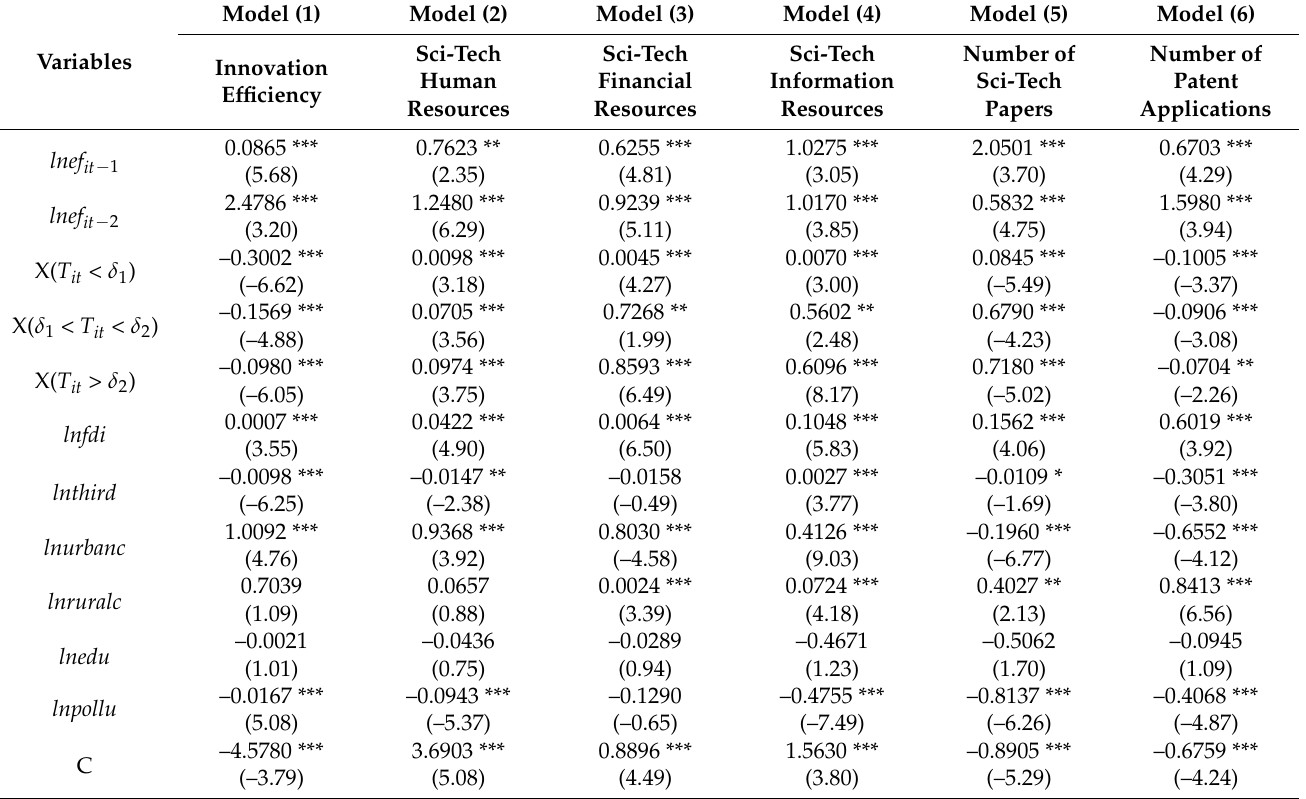
Table 8. Double-threshold model parameter estimation results of non-innovative